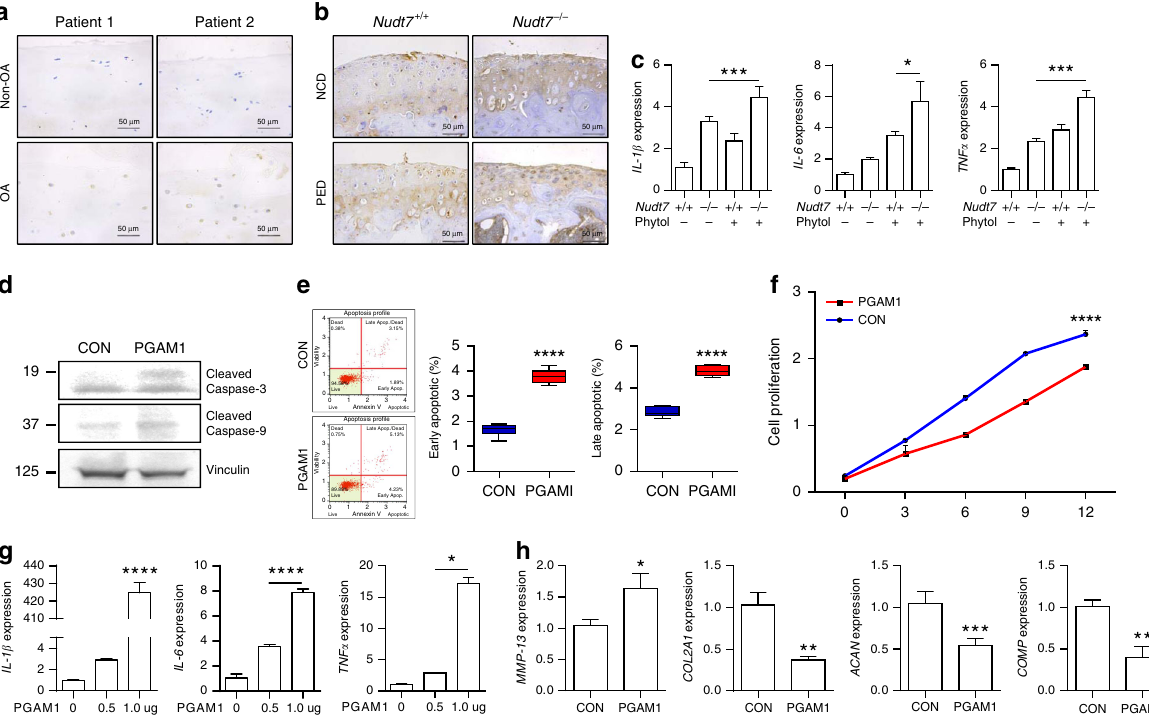
Fig. 4 Upregulation of phosphoglycerate mutase 1 ( PGAM1 ) expression induces pro-in fl ammatory cytokines. a Immunostaining of interleukin (IL)-1 β in human OA chondrocyte compared with non-OA chondrocyte ( n = 5 per group). b Immunostaining of IL-1 β cartilage of DMM-induced Nudt7 − / − mice ( n = 5 per group). c Transcription levels of IL-1 β , -6 , and TNF α in iMACs of Nudt7 − / − mice at postnatal day 6 under CON and phytol conditions ( n = 3 per group). d Immunoblotting of cleaved caspase-3 and -9 with the introduction of PGAM1 into iMACs of Nudt7 + / + mice. e , f Analysis of apoptotic cell death and cell proliferation with the introduction of PGAM1 into iMACs of Nudt7 + / + mice ( n = 6 per group). g Transcriptional level of IL-1 β , -6, and TNF α in iMACs of Nudt7 + / + mice at postnatal day 6 transfected with PGAM1 dose dependent ( n = 3 per group). h Transcriptional levels of MMP-13, COL2A1, ACAN , and COMP transfected with PGAM1 . Scale bars, 50 μ m. Values are means + s.d. An unpaired Student ’ s t test was used for statistical analysis. ** P < 0.01, *** P < 0.001, **** P <